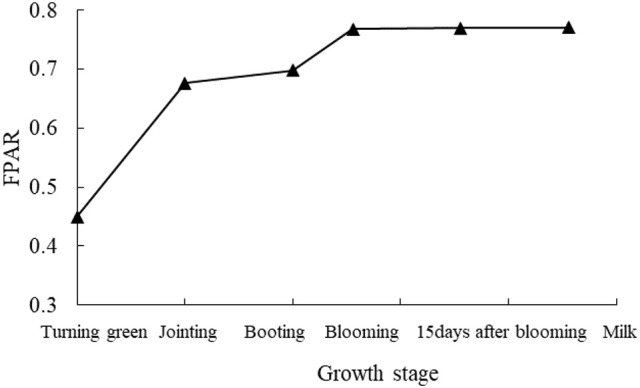
Changes of wheat canopy FPAR at different growth stages.